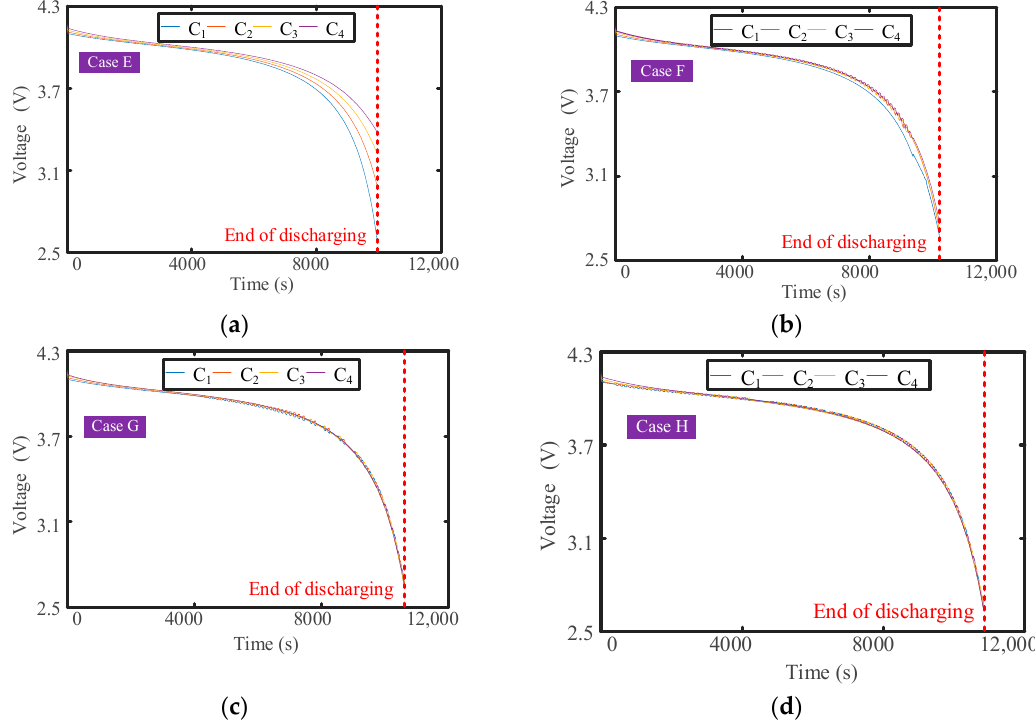
Figure 7. Simulation results of discharging equalization. ( a ) Case E: no equalization; ( b ) Case F: SOC of C 0 = 2%; ( c ) Case G: SOC of C 0 = 50%; and ( d ) Case H: SOC of C 0 = 98%. Table 3. Discharging time comparison.